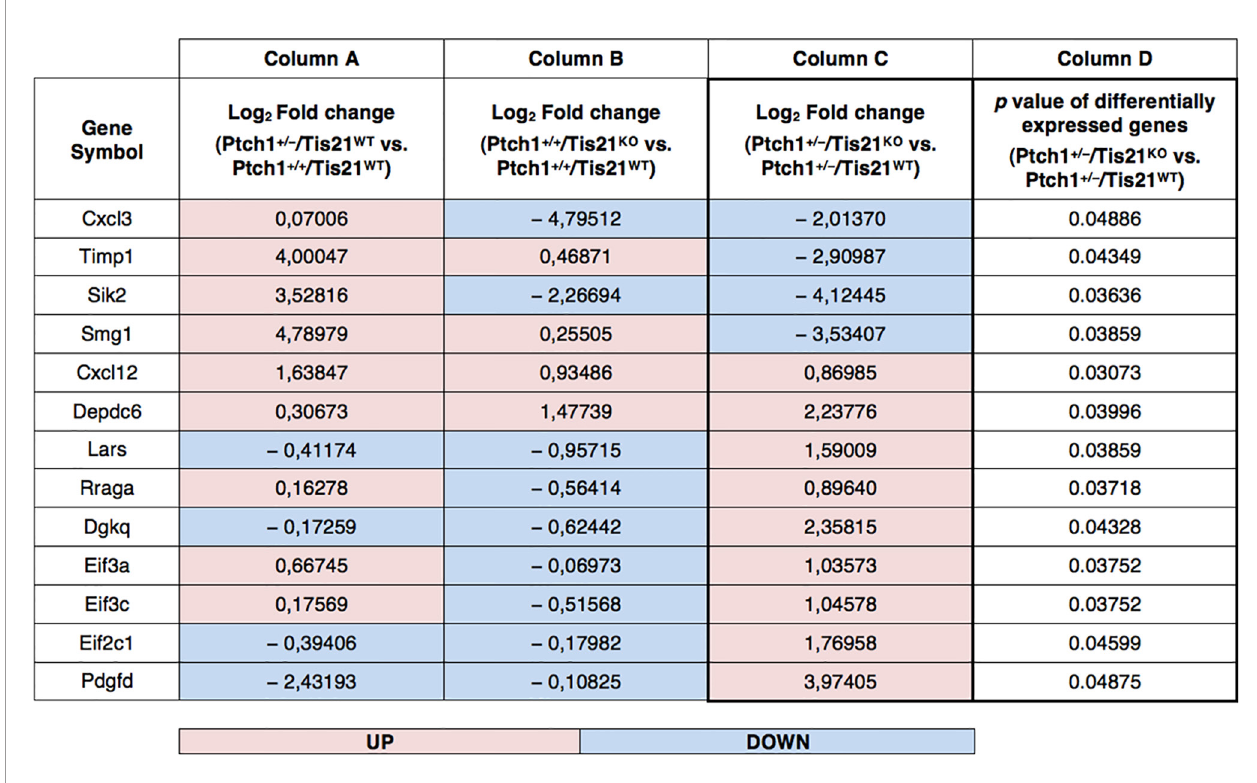
FIGURE 2 | PI3K/AKT/mTOR pathway-speci fi c differentially regulated gene expression in the Ptch1 +/ − /Tis21 KO MB mouse model. As described in our previously published data, we performed a functional genomic analysis by microarray of GCPs isolated from the EGL at P7 of Ptch1 +/+ /Tis21 WT , Ptch1 +/+ /Tis21 KO , Ptch1 +/ − / Tis21 WT and Ptch1 +/ − /Tis21 KO mice (27). Through further analysis of these data, we now identify 13 genes, shown here, encoding for proteins involved in the PI3K/ AKT/mTOR pathway (see Figure 1 ), whose expression signi fi cantly differs in the pairwise comparison Ptch1 +/ − /Tis21 KO versus Ptch1 +/ − /Tis21 WT (column D ). The deregulation of these genes could explain, at least in part, the large increase in MB frequency observed in Ptch1 +/ − /Tis21 KO relative to Ptch1 +/ − /Tis21 WT mice. Of note, among the 13 PI3K/AKT/mTOR pathway-speci fi c genes, the majority of them showed concordant expression changes between the pairwise comparison Ptch1 +/+ /Tis21 KO vs. Ptch1 +/+ /Tis21 WT (column B ) and the pairwise comparison Ptch1 +/ − /Tis21 WT vs. Ptch1 +/+ /Tis21 WT (column A ), and opposite expression changes with respect to the pairwise comparison Ptch1 +/ − /Tis21 KO versus Ptch1 +/ − /Tis21 WT (column C ). This suggests that the activation of the PI3K/AKT/mTOR signaling is the result of a synergy between the Ptch1 +/ − and Tis21 KO genotypes. The data in columns (A – C) are expressed in terms of log 2 fold-changes of gene expression; the colors indicate overexpression (pink) or down-expression (light blue) of genes, relative to the median value. The p values of differentially expressed genes in the pairwise comparison Ptch1 +/ − /Tis21 KO versus Ptch1 +/ − /Tis21 WT , reported in column (D) , are calculated as described in the section Microarray Analysis